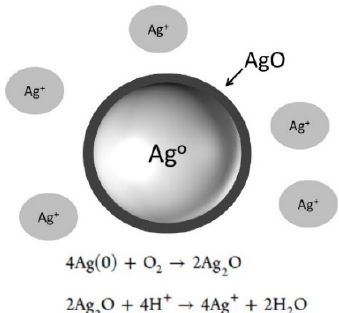
Figure 3. Mechanism for the dissolution of silver nanoparticles in an aqueous environment. The dissolved silver ions are the species killing bacteria.